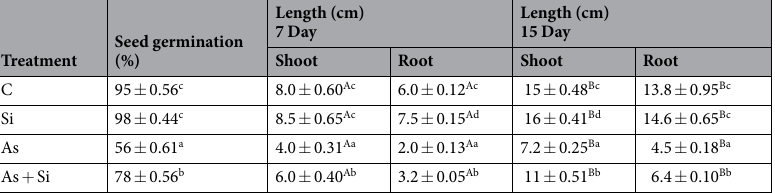
Table 1. Effect of Si on percentage seed germination and shoot-root length in Oryza sativa var. IR64 treated with or without As (III) at 7 and 15d exposure period. Different letters represent significant differences between each treatment at p < 0.05. The small latter (i.e. a, b, c and d) indicates the significant difference between